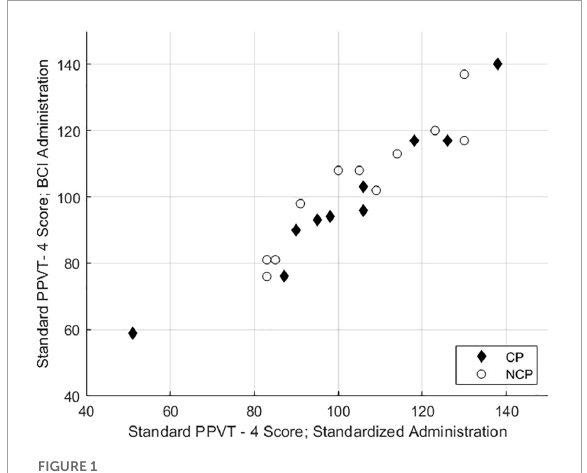
FIGURE1 Scatterplot of standard and BCI-facilitated PPVT-IV standard scores for participants with or without